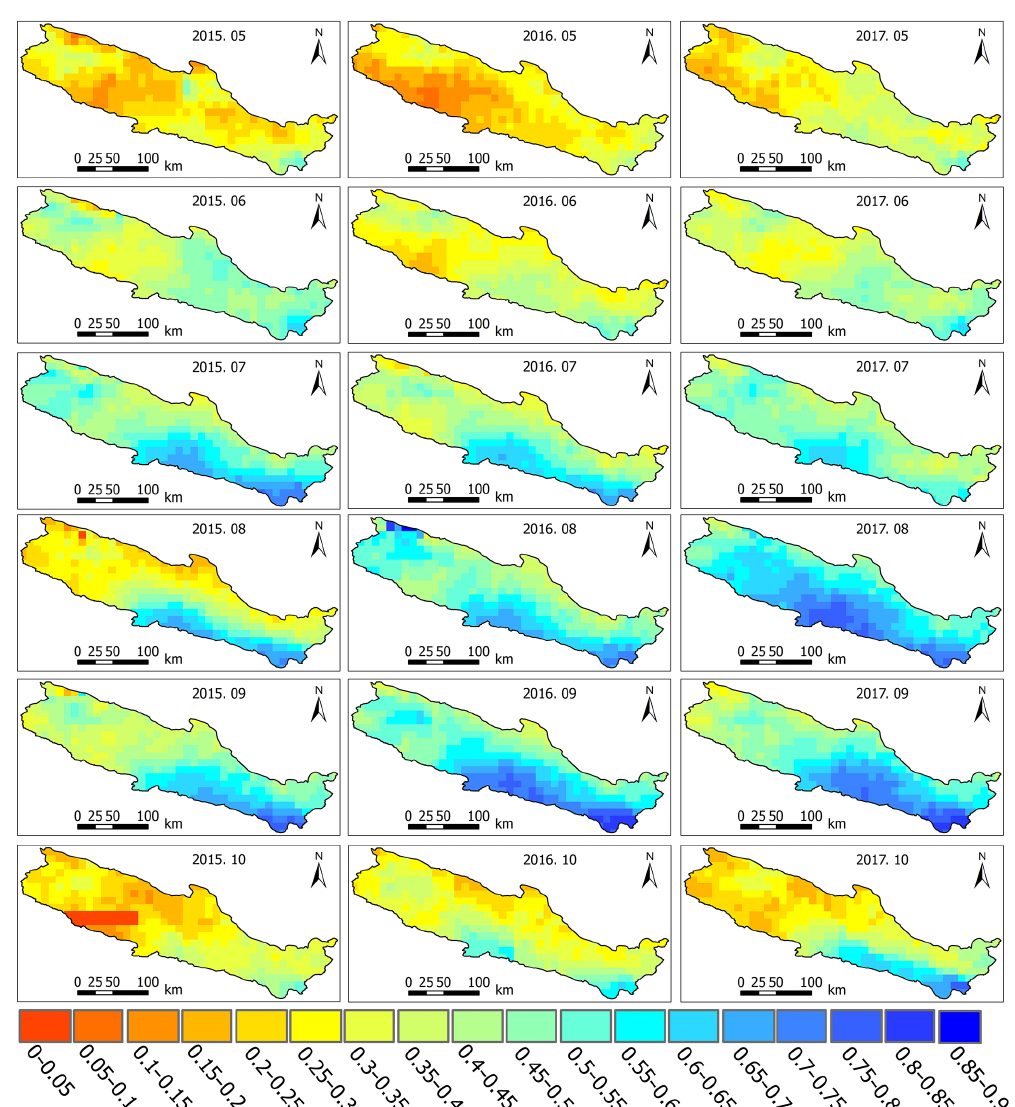
Figure 8. The spatial distribution of the monthly averaged profile SWI product estimated from the SMAP_L3 surface product during the growing seasons from 2015 to 2017. The title of each subplot provides the month and